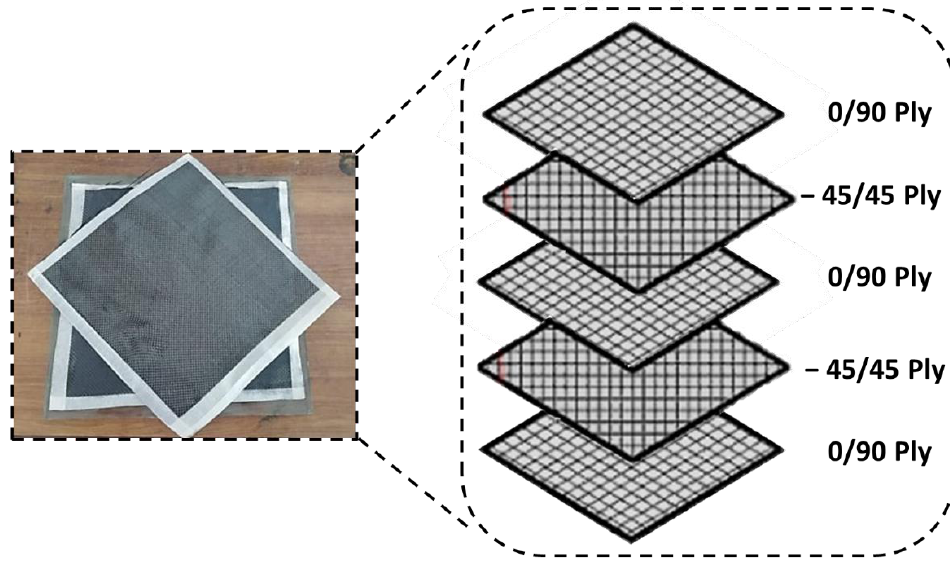
Figure 1. Multidirectional quasi- isotropic [0/90/+45/−45]